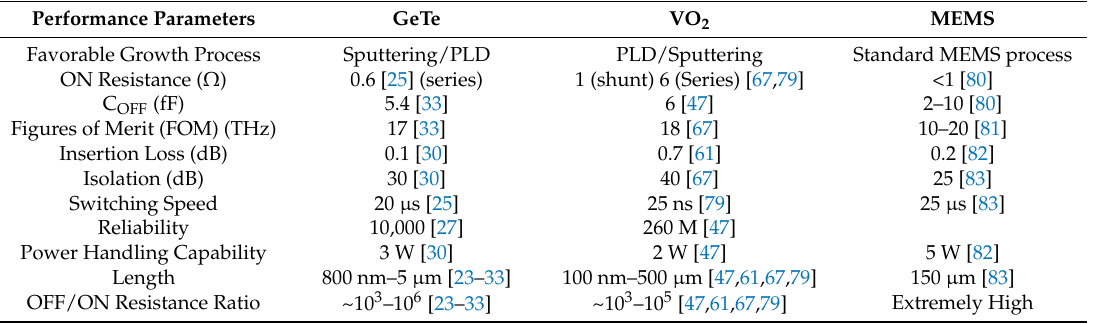
Table 1. Reported best values for each RF performance parameter irrespective of growth process, design, device geometry and